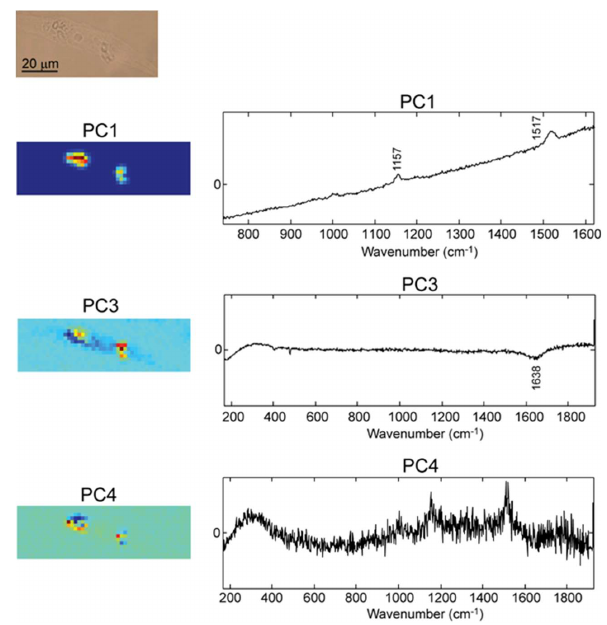
Figure 6. From top to bottom: Optical microscopy image of a D407 cell transfected with beta-carotene loaded PEM capsules followed by the Raman score plots (maps) and the corresponding loading plots of relevant principal components PC1, PC3, and